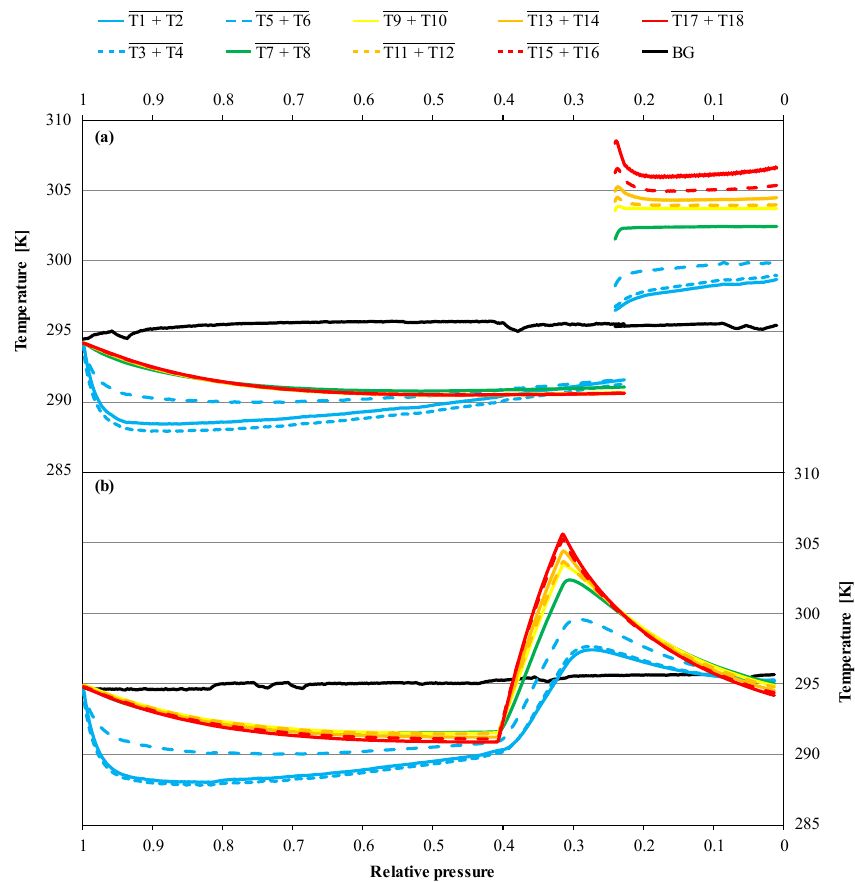
Figure 16. Temperature measurements against relative pressure; note the inverse x axis. Because the initial pressures of the cylinders were slightly different (CB11941 at 130.5bar and CB12009 at 124.0bar, respectively), the pressure is expressed as relative pressure ( P/P 0 ) in order to use the same x axes for both panels. Panel (a) shows the temperature measurements of a high-flow experiment where a horizontally positioned cylinder (CB11941 on 21 June 2017) was measured until it reached 30bar. At 30bar, the flow was stopped and the heating turned on. After the thermostat read 30 ◦ C, the flow was switched back on and the measurement continued with the heating keeping it at a steady temperature until the end. The heating created a small pressure increase which is responsible for the small overlap in the x axis and is clearly visible in the background temperature. Panel (b) shows a high-flow experiment, where a vertically positioned cylinder (CB12009 on 26 September 2017) got a burst of heat at 50bar. The heating was maintained until the thermostat read 30 ◦ C. After reaching the threshold, the heating was switched off (at 40.8bar). During the burst heating, the CO 2 measurements continued. The lines represent averages of the following thermistors. Pressure regulator to stem: solid blue, T1 and T2; dotted blue, T3 and T4; dashed blue, T5 and T6. Cylinder valve: green, T7 and T8. Cylinder body: yellow, T9 and T10; dashed orange, T11 and T12; solid orange, T13 and T14; dashed red, T15 and T16; solid red, T17 and T18. Laboratory background: black, T19 to